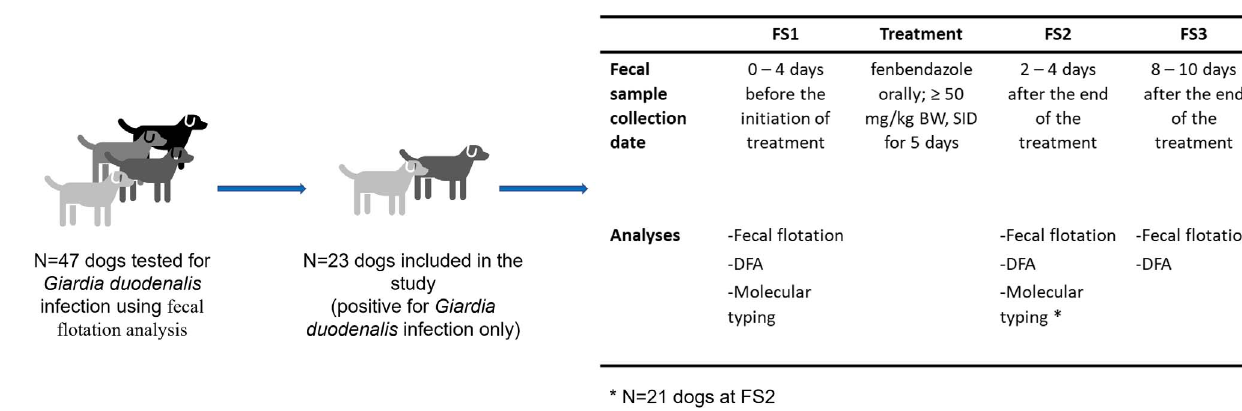
Figure 1. Work fl ow of the study protocol. FS: fecal samples, DFA: direct immuno fl uorescence